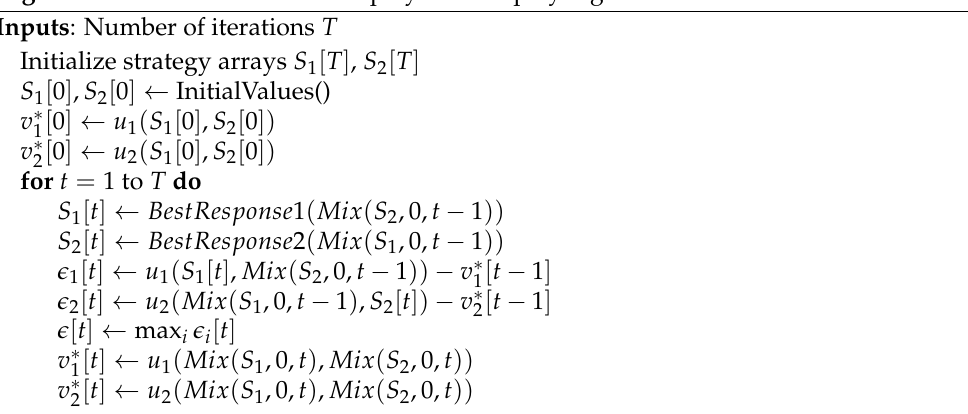
Algorithm 1 Redundant fictitious play for two-player